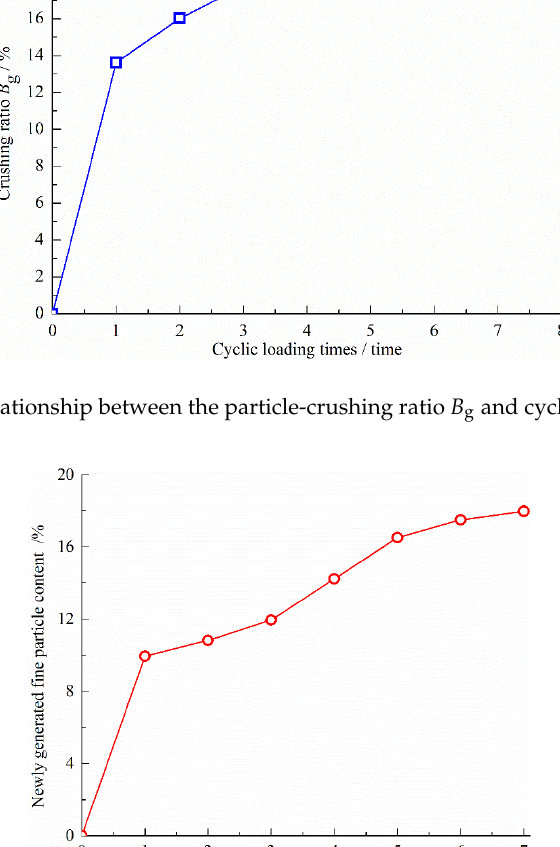
Figure 8. The relationship between newly generated fine particle content and cyclic loading times.